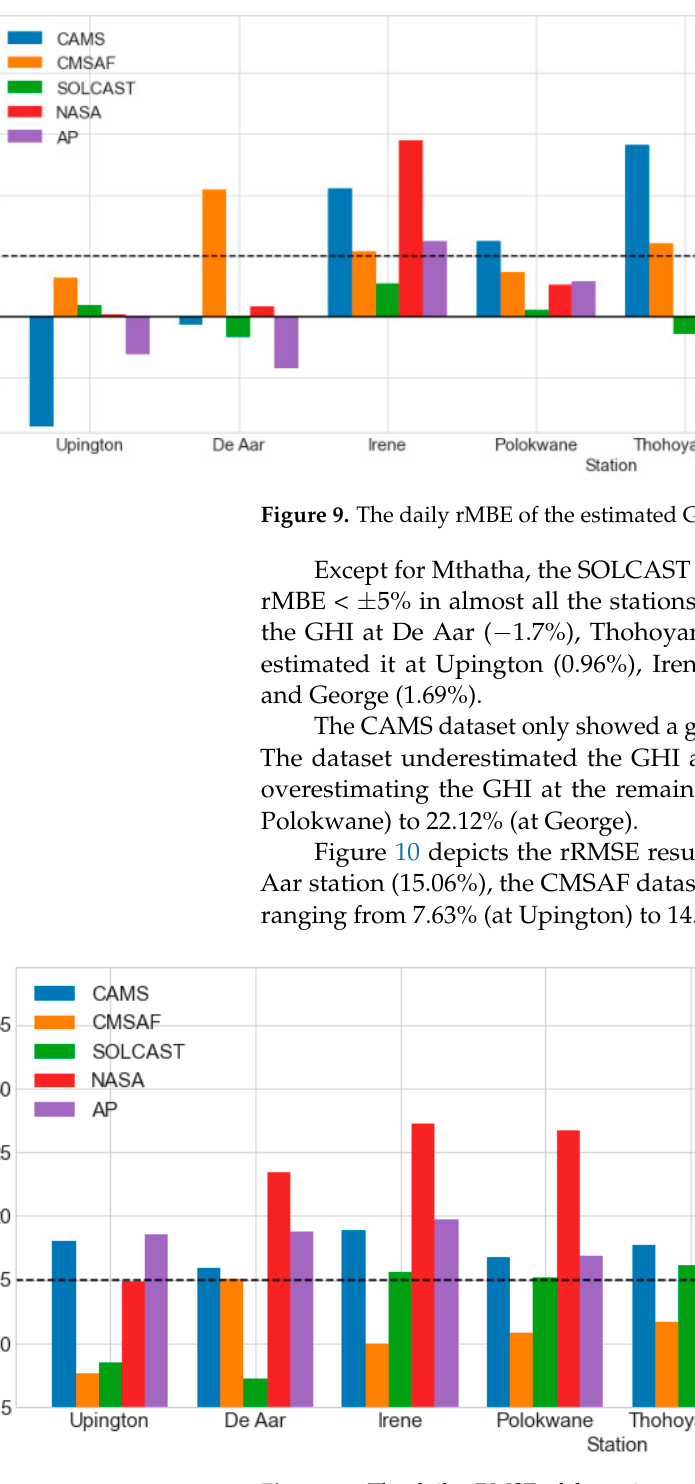
Figure 10. The daily rRMSE of the estimated GHI datasets under overcast-sky conditions. For the CAMS dataset, no station performed well (rRMSE > 15%); the rRMSE ranged from 15.96% (at De Aar) to 28.56% (at George). The AP model performed poorly, with rRMSE ranging from 16.84% (at Polokwane) to 29.67% (at Durban). SOLCAST performed well (rRMSE 15%) in Upington (8.49%) and De Aar (7.29%), but poorly at the other stations, with rRMSE ranging from 15.22% (at Polokwane) to 19.58% (at George). The NASA SSE data collection performed admirably.